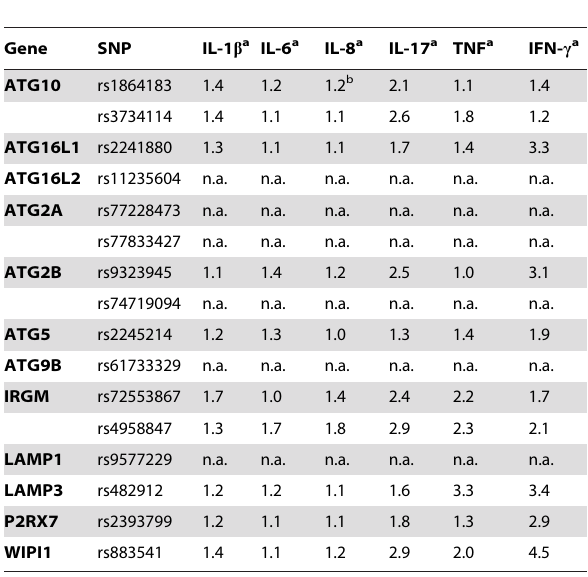
a Values are expressed as the ratio of cytokine production associated with different genotypes (median for all individuals bearing the same genotype), using the genotype groups with the highest and lowest cytokine production. b Significantly differences (P , 0.05) in genotype groups with highest and lowest cytokine production calculated by Wilcoxon signed rank test. n.a. not analysed; SNP not polymorphous in this